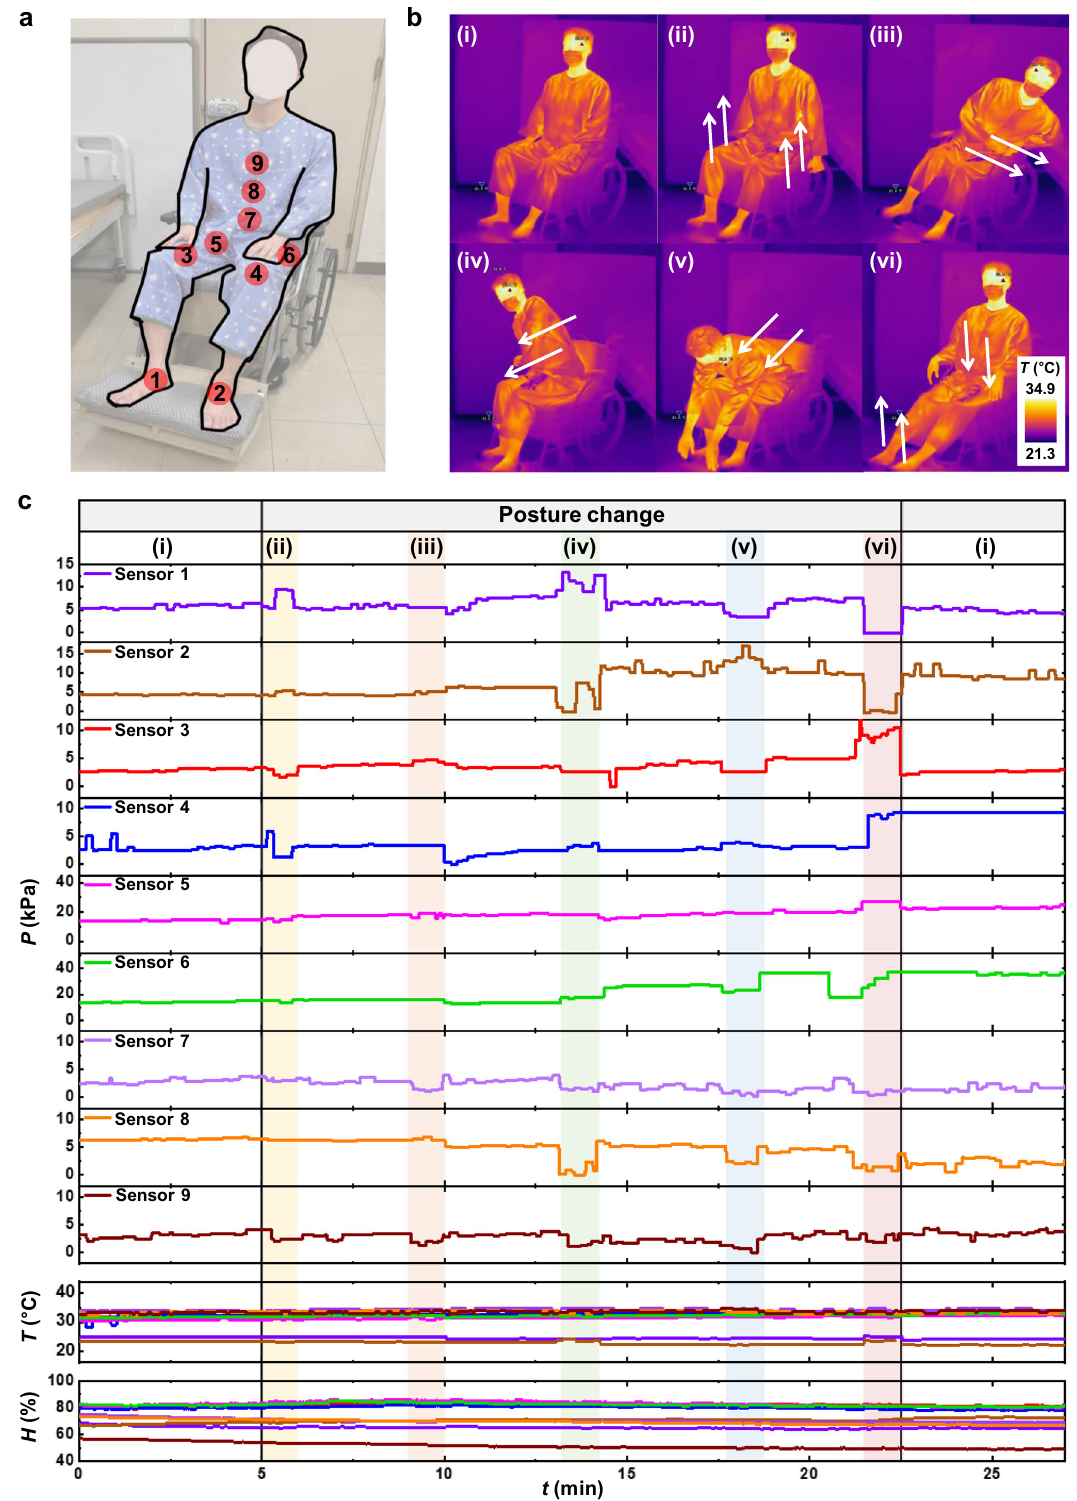
Fig. 5 Continuous measurement of pressure, temperature, and hydration from a healthy subject. a Photograph of the subject sitting in a wheelchair. Red discs mark the mounting locations of the devices. b IR images of postural changes of the subject for self-repositioning. (i) Base position. (ii) Push-up weight shift. (iii) Left-side lateral weight shift. (iv) Right-side lateral weight shift. (v) Anterior weight shift. (vi) Lifting both feet. c Results from continuous measurement of pressure, temperature, and hydration from each of the sensors under posture changes in